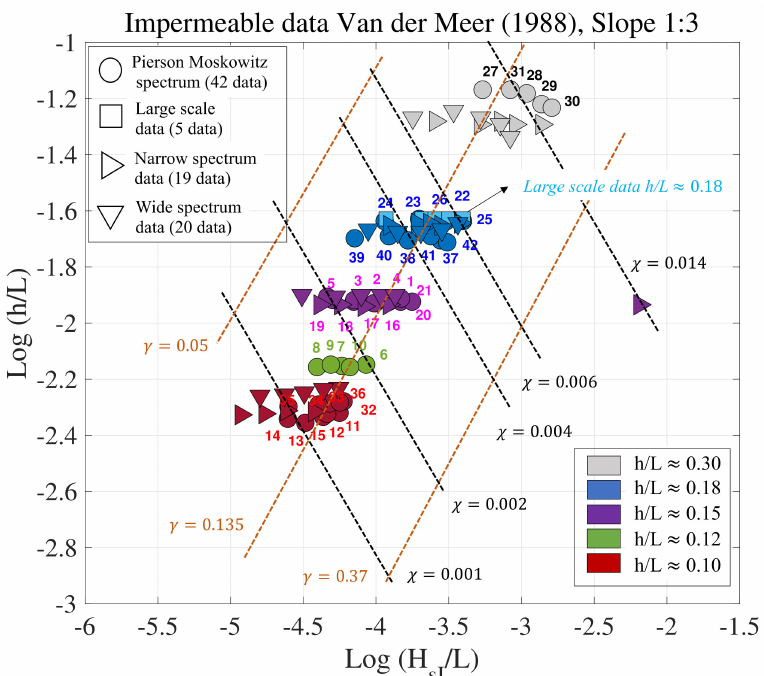
Figure 2. Experimental space of Van der Meer’s data [28] for an impermeable core and slope 1:3. The orange lines and black lines represent the isolines with constant value of γ and χ . By color the values of relative water depth h / L , at the toe of the slope, are identified. The data were taken from